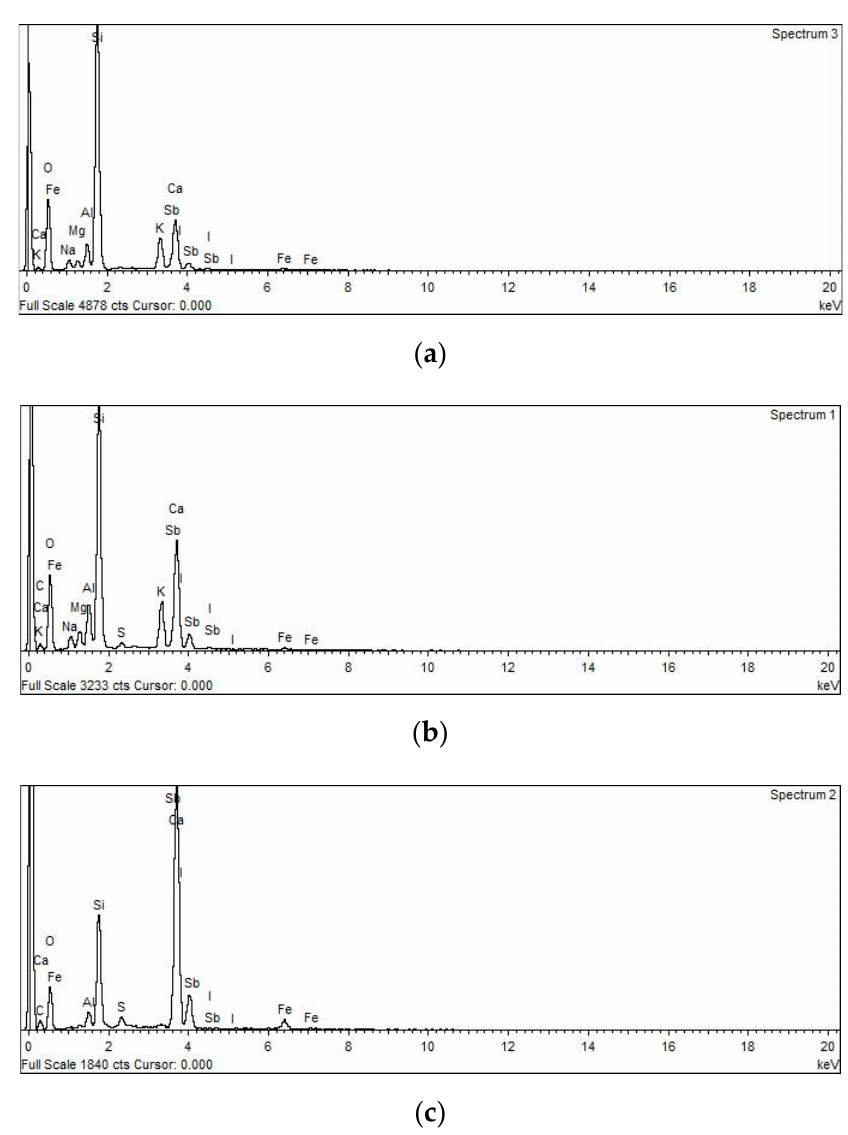
Figure 14. EDX analysis of UHPGC mixtures, ( a ) G1; ( b ) G5; ( c ) G7.